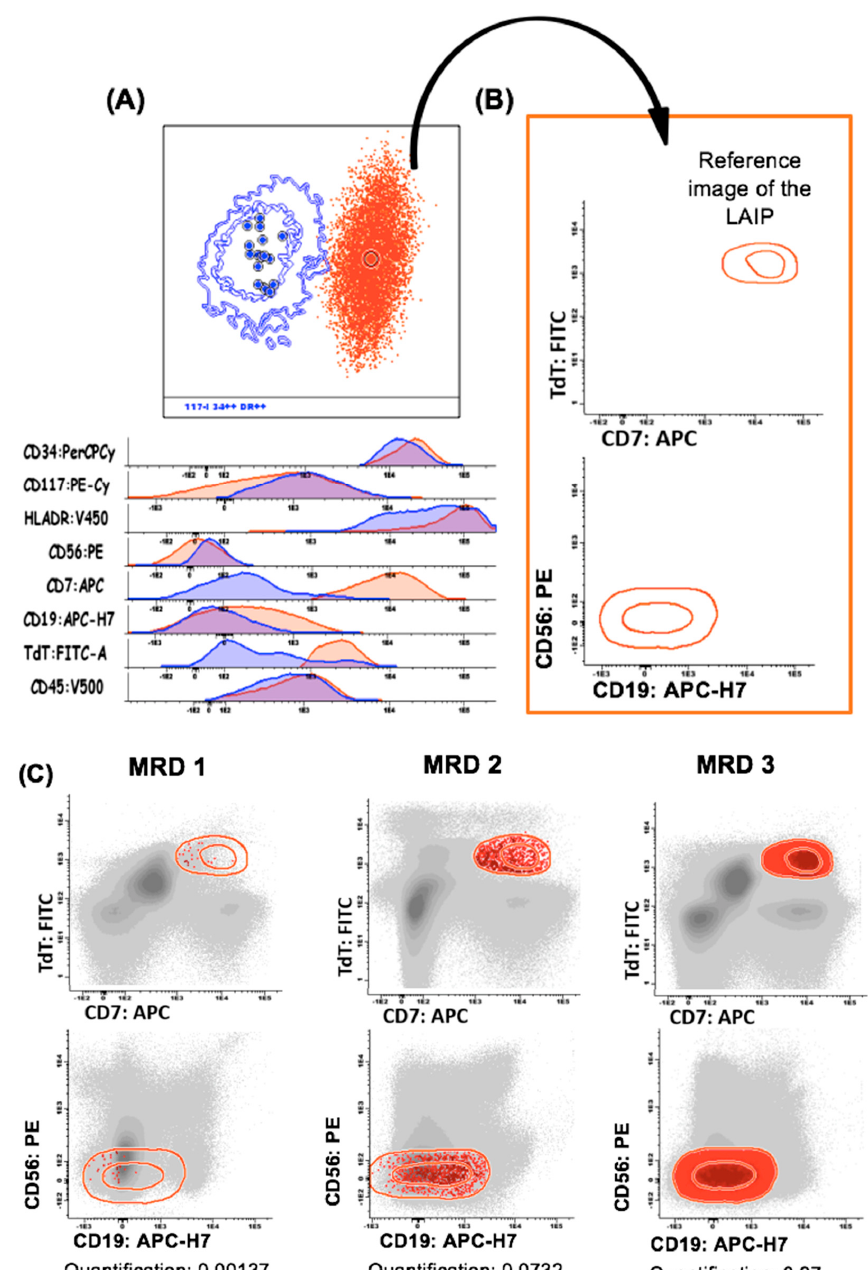
Figure 4. Creation of the reference images for the successive MRD monitoring. ( A ) The leukemic population at diagnosis (orange) was compared with its theoretical normal counterpart (blue) and the LAIP was defined as follows: compartment I- CD7hi, TdThi, CD19hi and CD56hi. ( B ) A reference image of the leukemic cluster was automatically created to investigate the LAIP’s cut-off in normal/regenerative samples. This case showed a high sensitivity LAIP (individual threshold of 0.00154) at diagnosis. ( C ) Results of three successive MRD evaluations. MRD-1 = negative (threshold) and MRD-3 = positive (>0.1%).